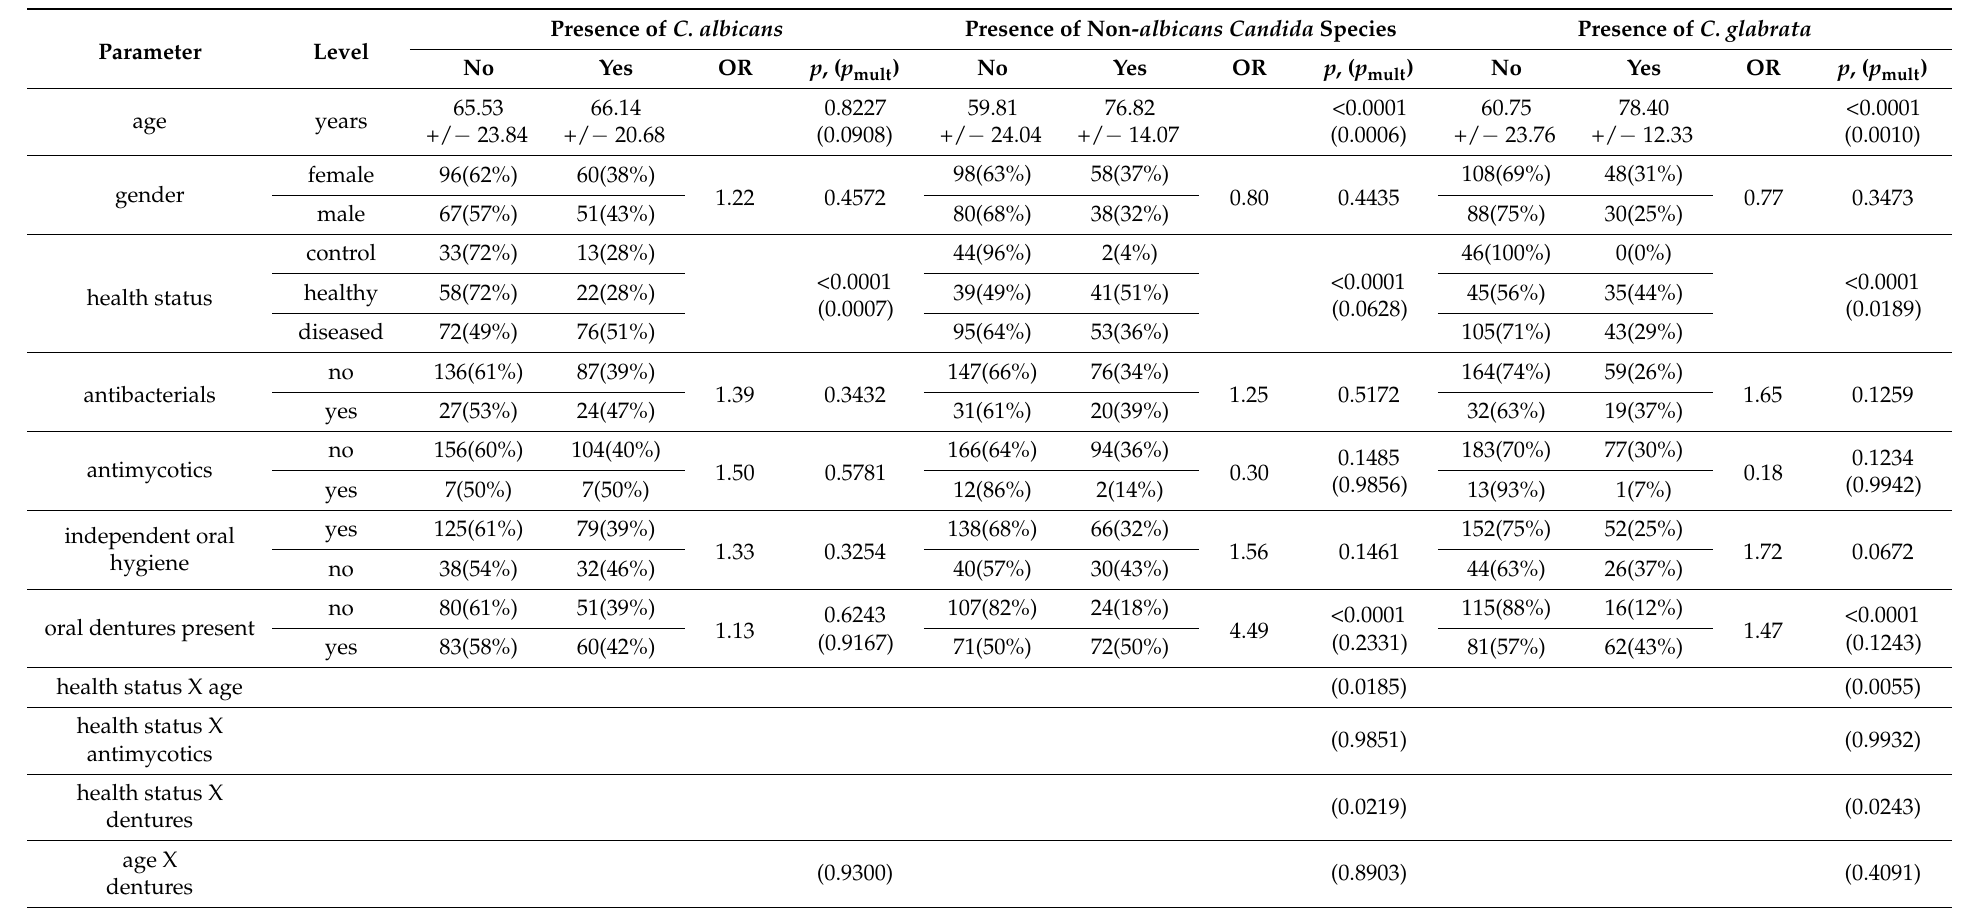
Table 3. Patient characteristics and correlations with yeast colonization of the oral